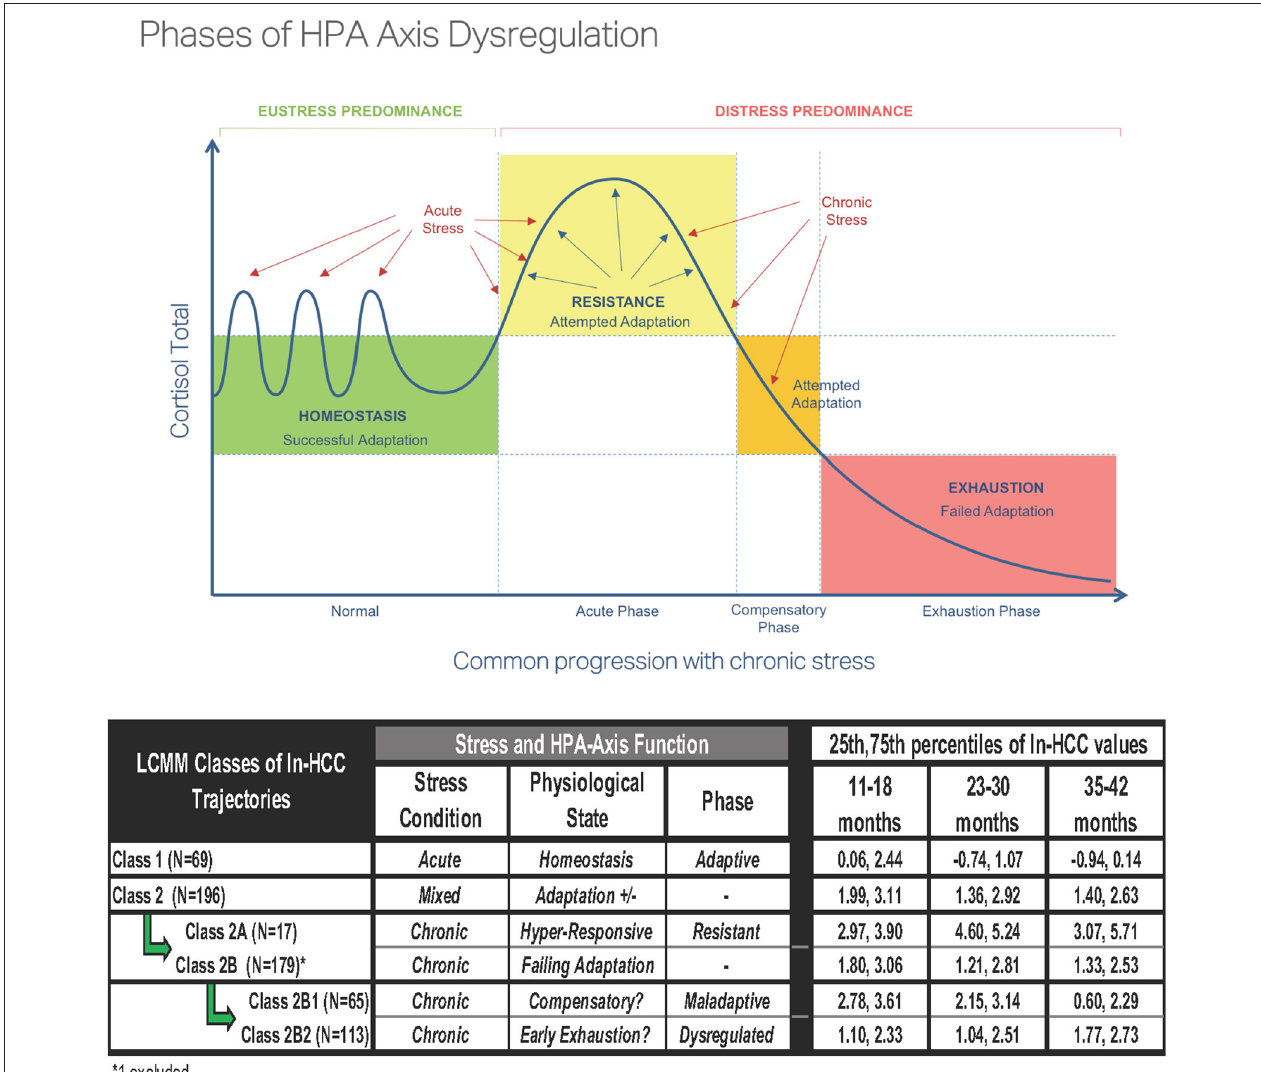
FIGURE 4 | Phases of hypothalamic-pituitary-adrenal (HPA)-axis dysregulation [reproduced with permission from Bella Lindemann (www.bellalindemann.com)] based on animal studies. Eustress predominance under conditions of adaptive stress exposure to normal environmental conditions promotes maturation of the HPA-axis in early life. Distress predominance with worsening exposures to early life adversity in the absence of socially affiliative/nurturing relationships leads to a maladaptive (hyperresponsive) HPA-axis and delayed return to homeostasis. Severe or multiple chronic stressors can disrupt cortisol secretion with the hypocortisolemia associated with HPA-axis dysregulation. Proposed variations in HPA-axis function for the LCMM Classes showing the 25th and 75th percentiles of ln-HCC values in each latent